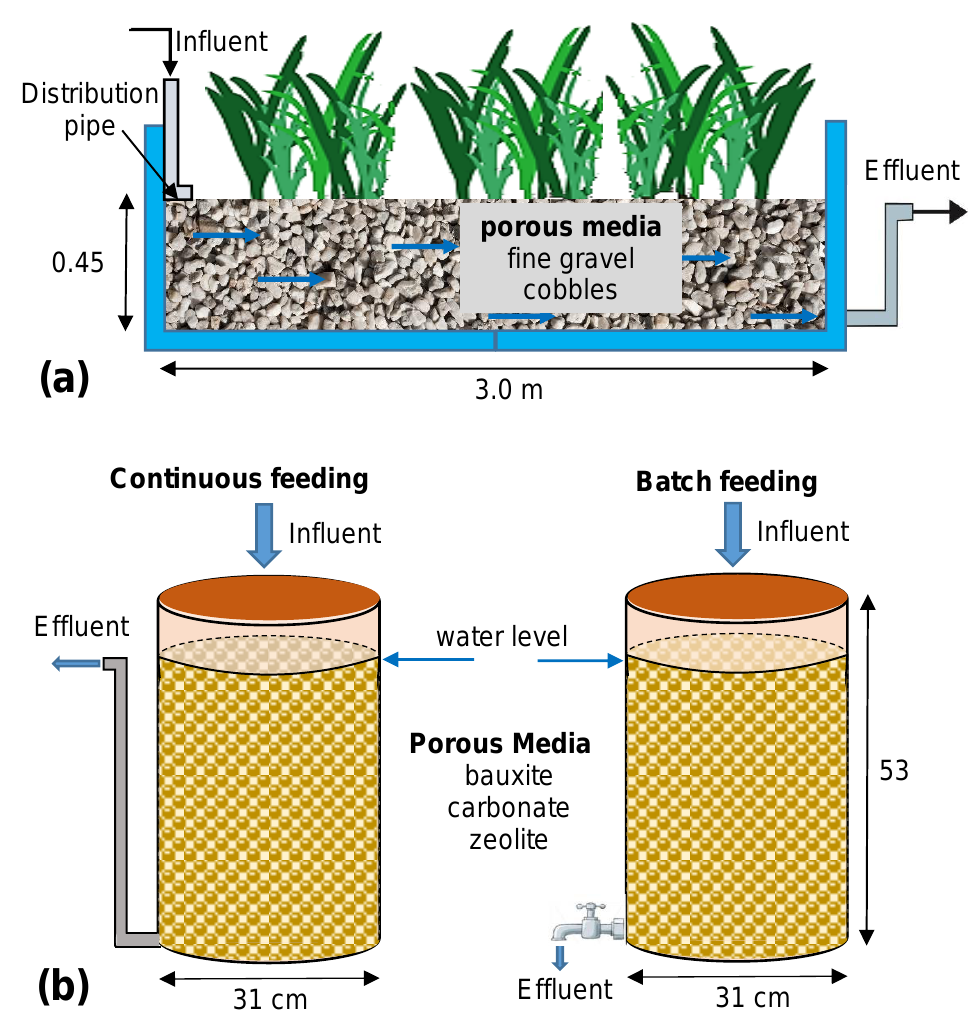
Figure 1. Schematic layout (not to scale) of: ( a ) pilot-scale CW unit; ( b ) gravity filters. Table 2. Design and operational characteristic of HSF-CWs and gravity filter units. Constructed Wetlands